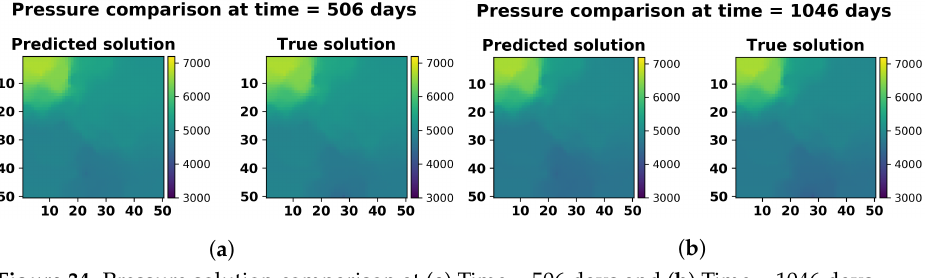
Figure 34. Pressure solution comparison at ( a ) Time = 506 days and ( b ) Time = 1046 days.